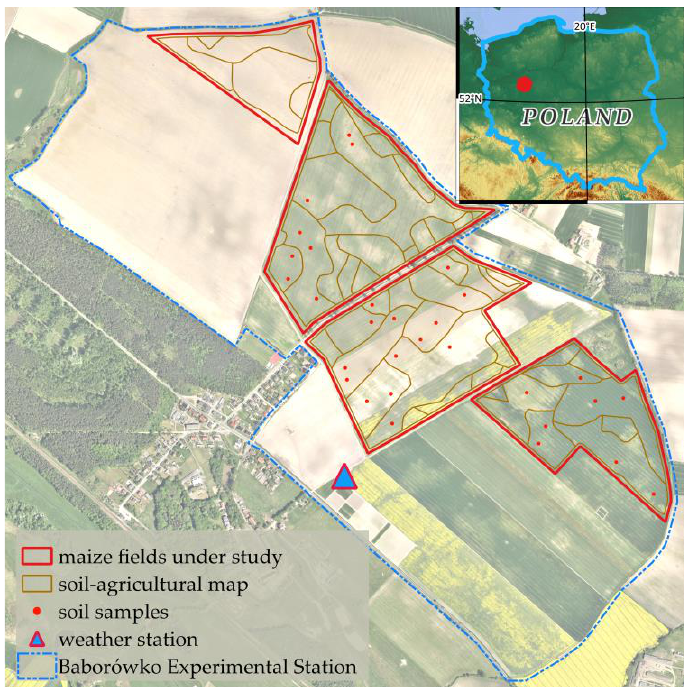
Figure 1. Localization of the study area — Baborówko Experimental Station (BES).